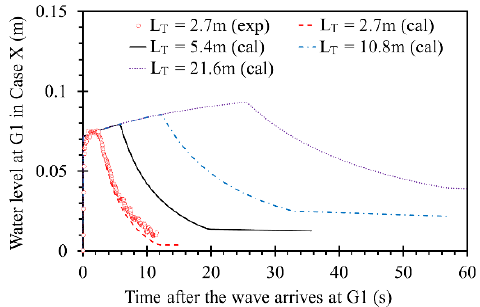
Figure 6. Time series of water level at G1 in Case X when H T = 0.25 m with changing tank length (L T ) in Figure 2. (L T ) in Figure